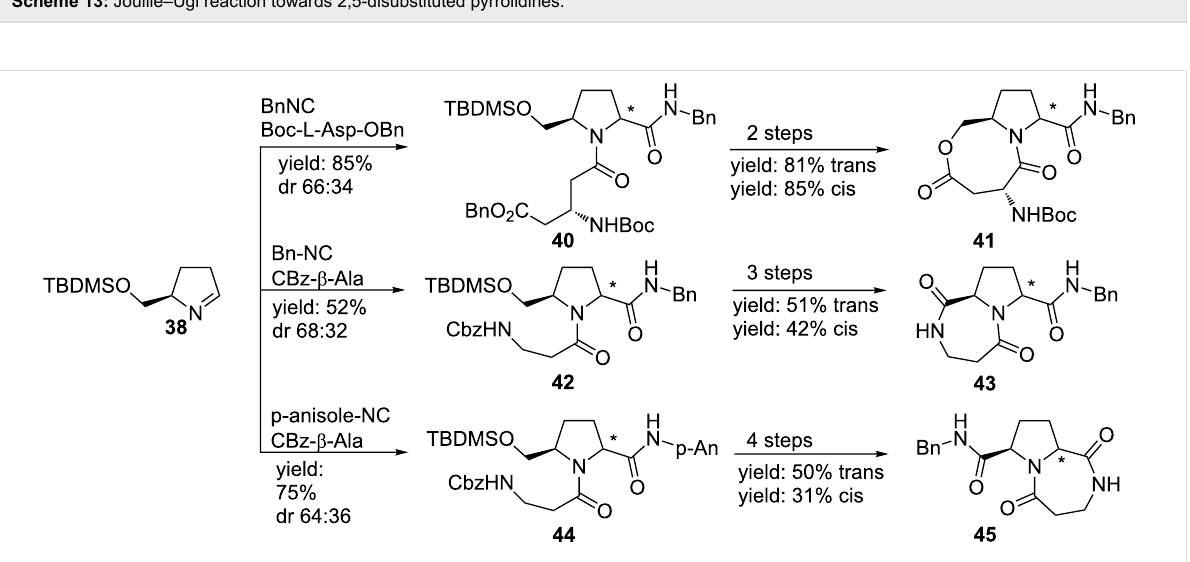
Scheme 14: Further elaboration of the Ugi-scaffold towards bicyclic